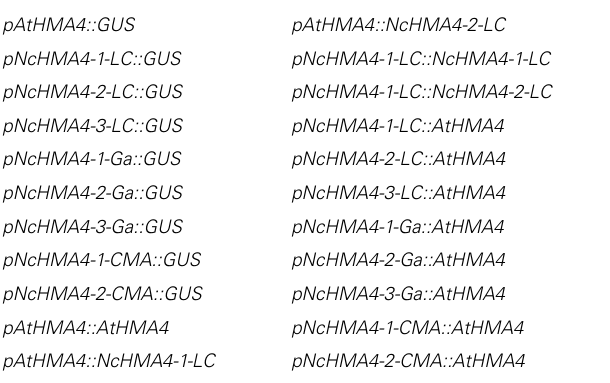
Table 1 | Constructs used for A. thaliana transformation and phenotyping experiments. For HMA4 , cDNA was